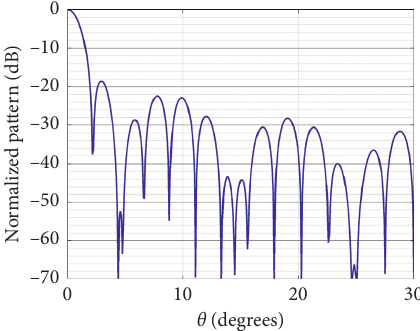
Figure 5: The array factor for N � 64 and M � 40. The 4 th and 5 th SLLs are approximately equal.